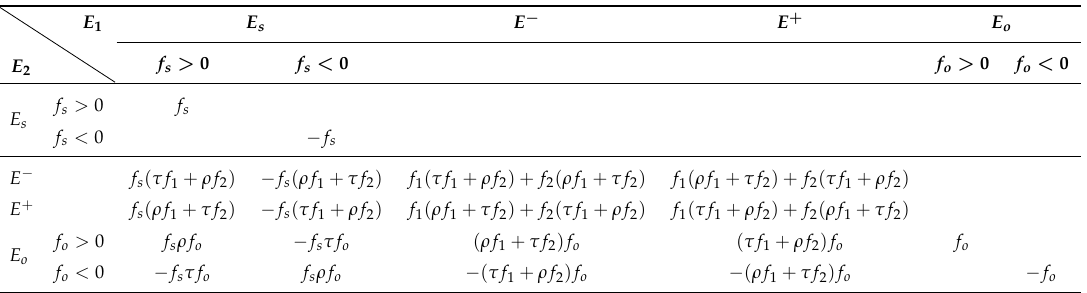
Table 2. Expressions of scattering and extinction coefficients for the possible combinations of incident ( E 1 ) and scattered ( E 2 ) fluxes of single